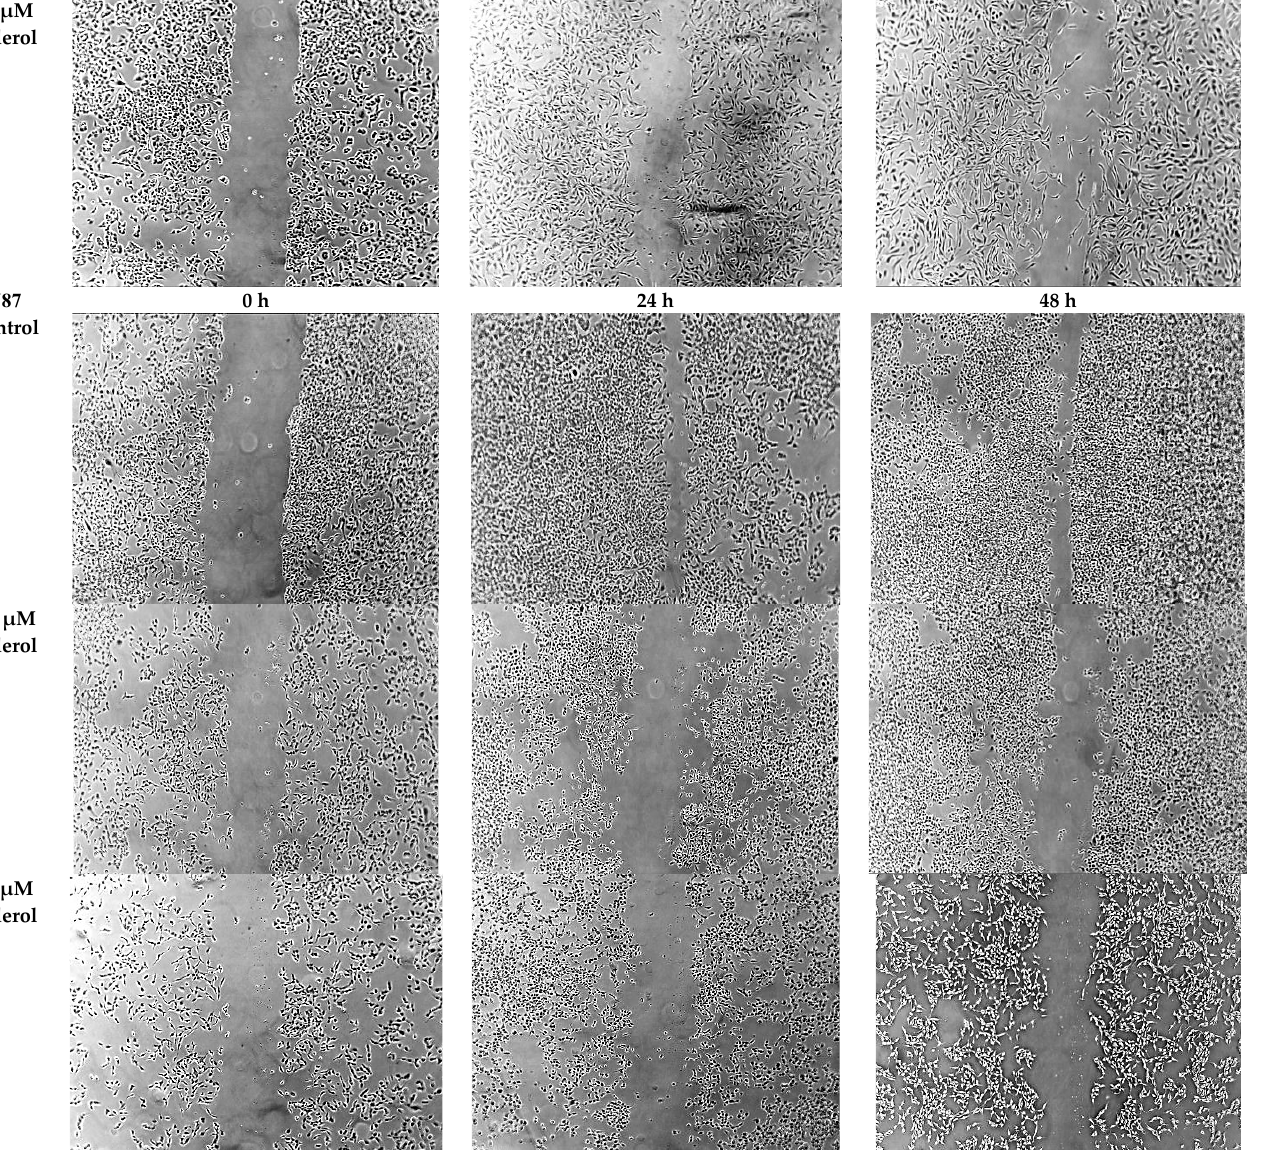
Figure 8. The effect of siderol on the migratory ability of T98 and U87 GBM cell lines at 0, 24, and 48 h, after treatment with IC50 and half IC50 values. Images were recorded at 5× magnification. Scale bars = 200 μ M.